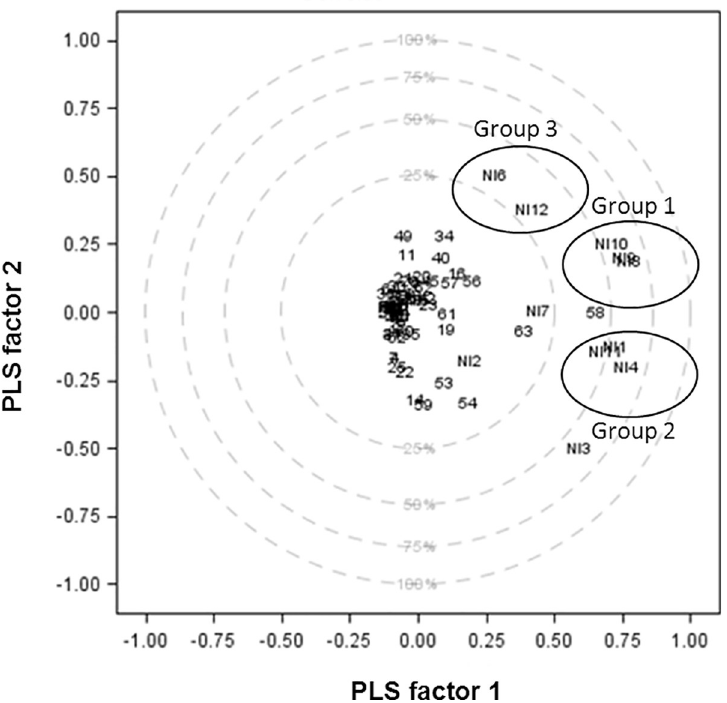
Fig 3. Correlation-loading plot of the relationships between nurse interviews overlaid with the themes in the 2 PLS factors space (N = 67). NI = Nurse Interview; Legend: Outer circle is the unit circle and indicates 100% of explained variance. Inner circle indicates 25% of explained variance. Numbers represents all the themes elicited during nurse interviews.